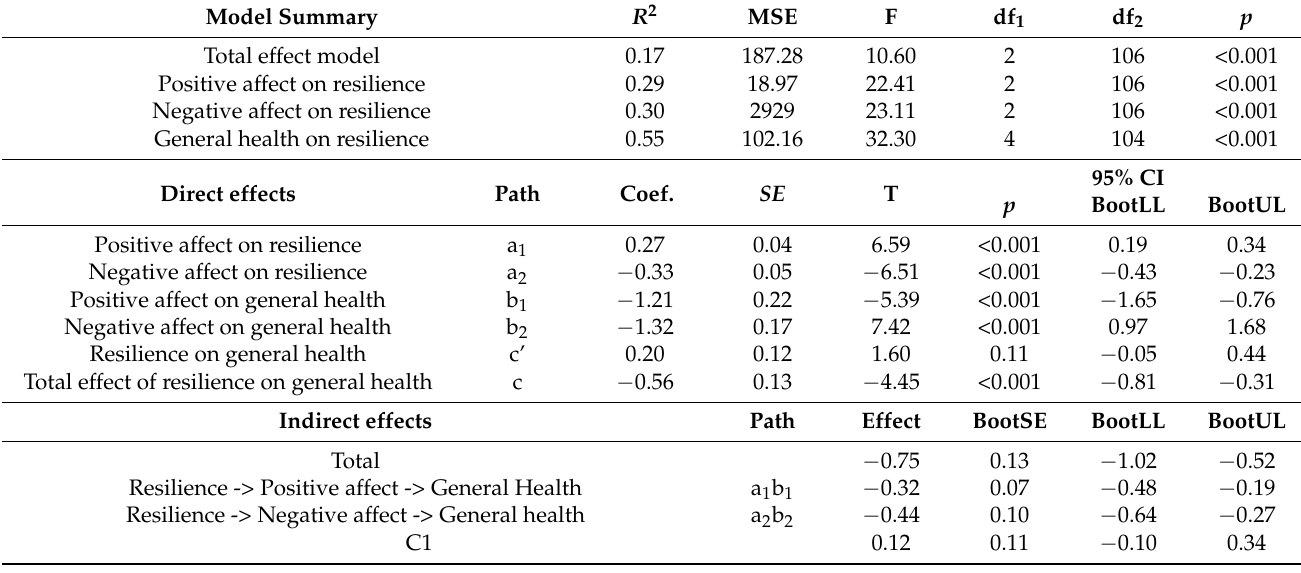
Table 3. Mediation model with model summary, direct effect, and indirect effect. Model